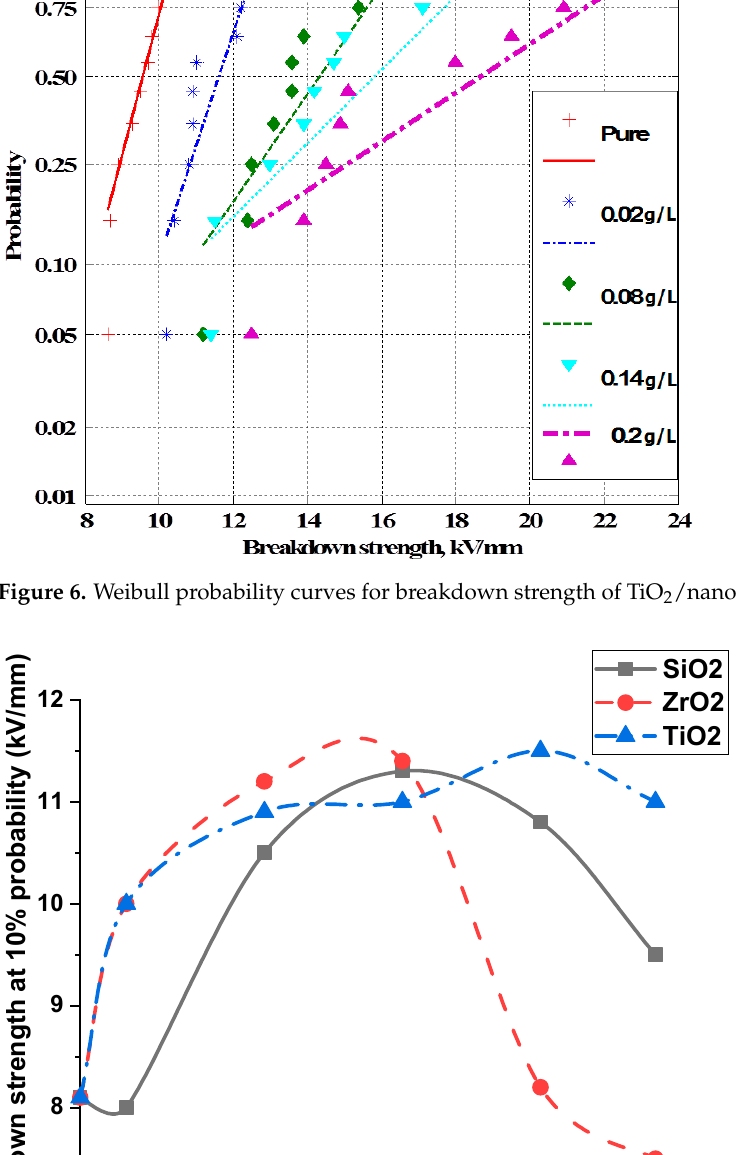
Figure 7. Breakdown strength at 10% probability of transformer oil containing different types of nanoparticles (SiO 2 , ZrO 2 and TiO 2 ).